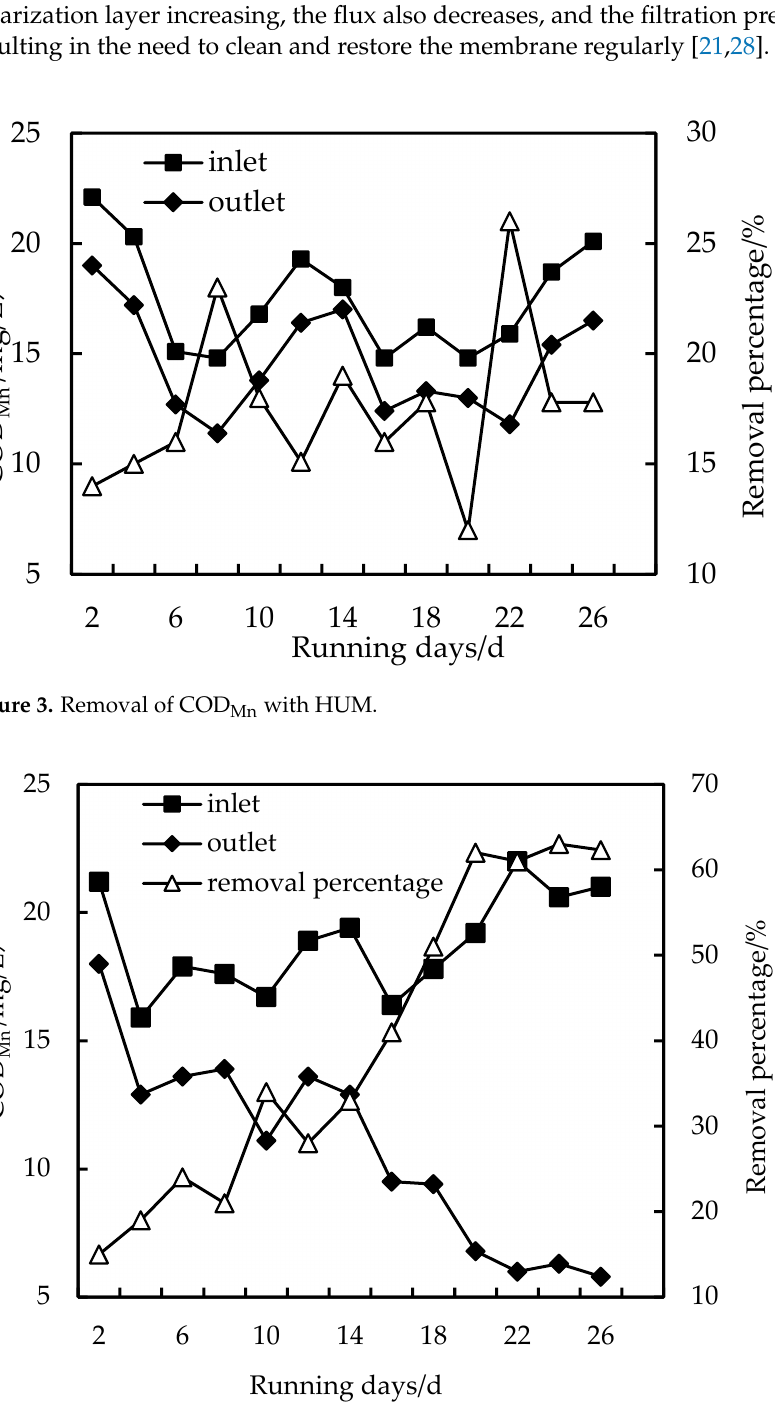
Figure 5. Removal effect of COD Mn with PAC dosage. 3.3. Removal of NH 3 -N As shown in Figure 6, the effect of HUM alone on NH 3 -N removal is not obvious, and the removal rate is about 5%. However, when PAC and HUM are combined, the removal rate of NH 3 -N increases because PAC forms a compacted layer on the HUM, which reduces the pore diameter of the membrane. As shown in Figure 7, the removal of NH 3 -N is divided into two stages: in the first stage, the removal rate of NH 3 -N is less than 10% at the initial stage of operation of the combined PAC-HUM process; after the system has operated for a period of time, the removal rate of NH 3 -N increases to 30%. In the second stage, after the membrane is backwashed, the NH 3 -N removal rate decreases, and as the experiment continues, the NH3-N removal rate starts to increase again, demonstrating that in the initial stage of operation until the membrane is backwash, pollutants in the raw water and PAC form a compacted gel layer on the membrane surface and inside the membrane pores, narrowing the membrane pore size and increasing the NH 3 -N removal rate. After backwashing, the gel layer falls off, increasing the pore size and decreasing the removal rate [23,24].